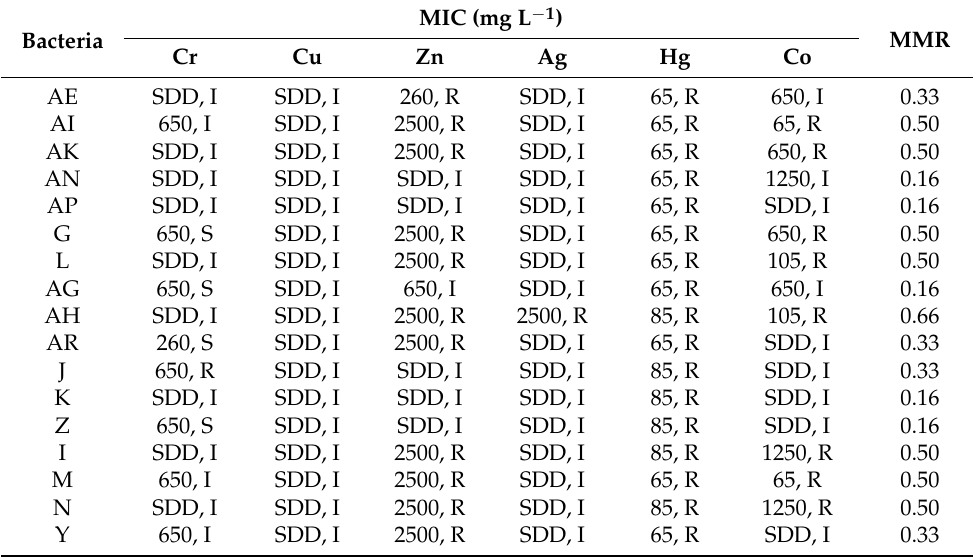
Table 3. Minimum inhibitory concentration and sensibility of the bacterial